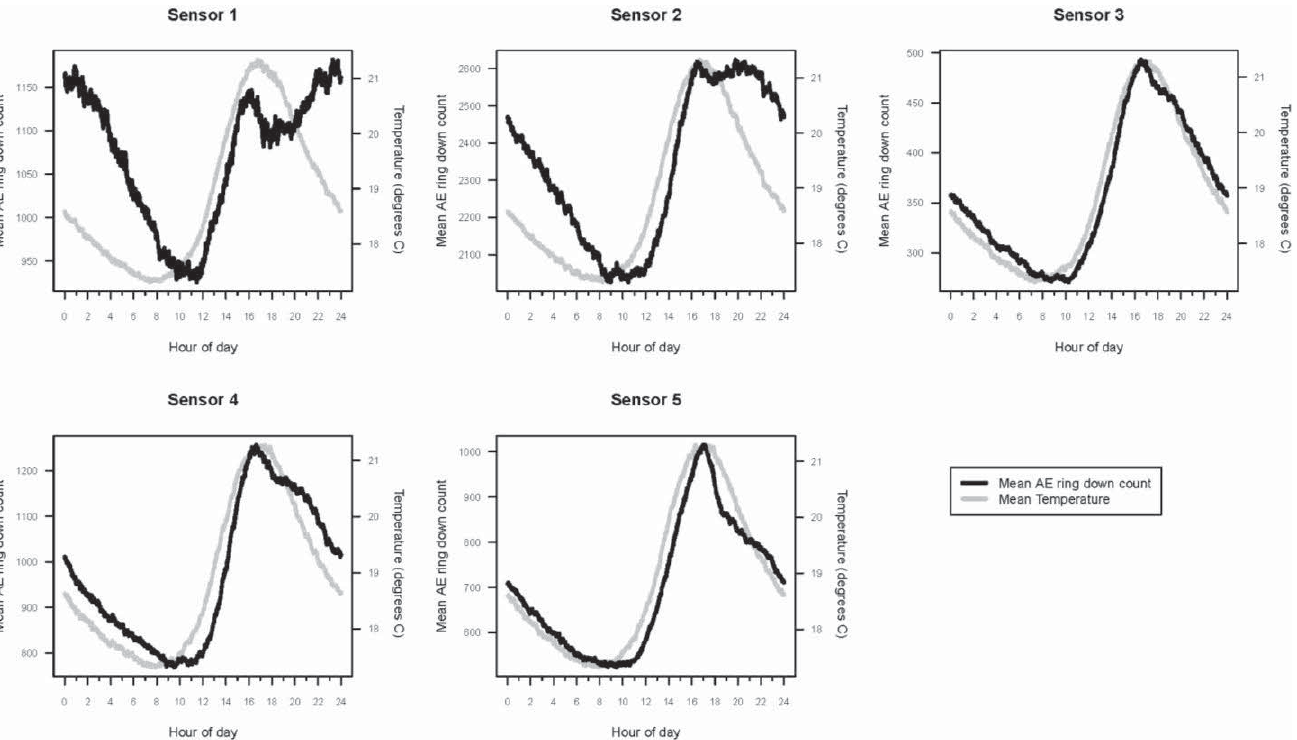
Figure 3. Mean daily activity patterns for I. minor in each of five logs (sensors 1 – 5). The heavy, dark line is the mean AE ring down count. The gray line is the temperature trace (°C) collected simultaneously for each AE data point. AE data for all logs were collected from 15 June 2008 to 15 May